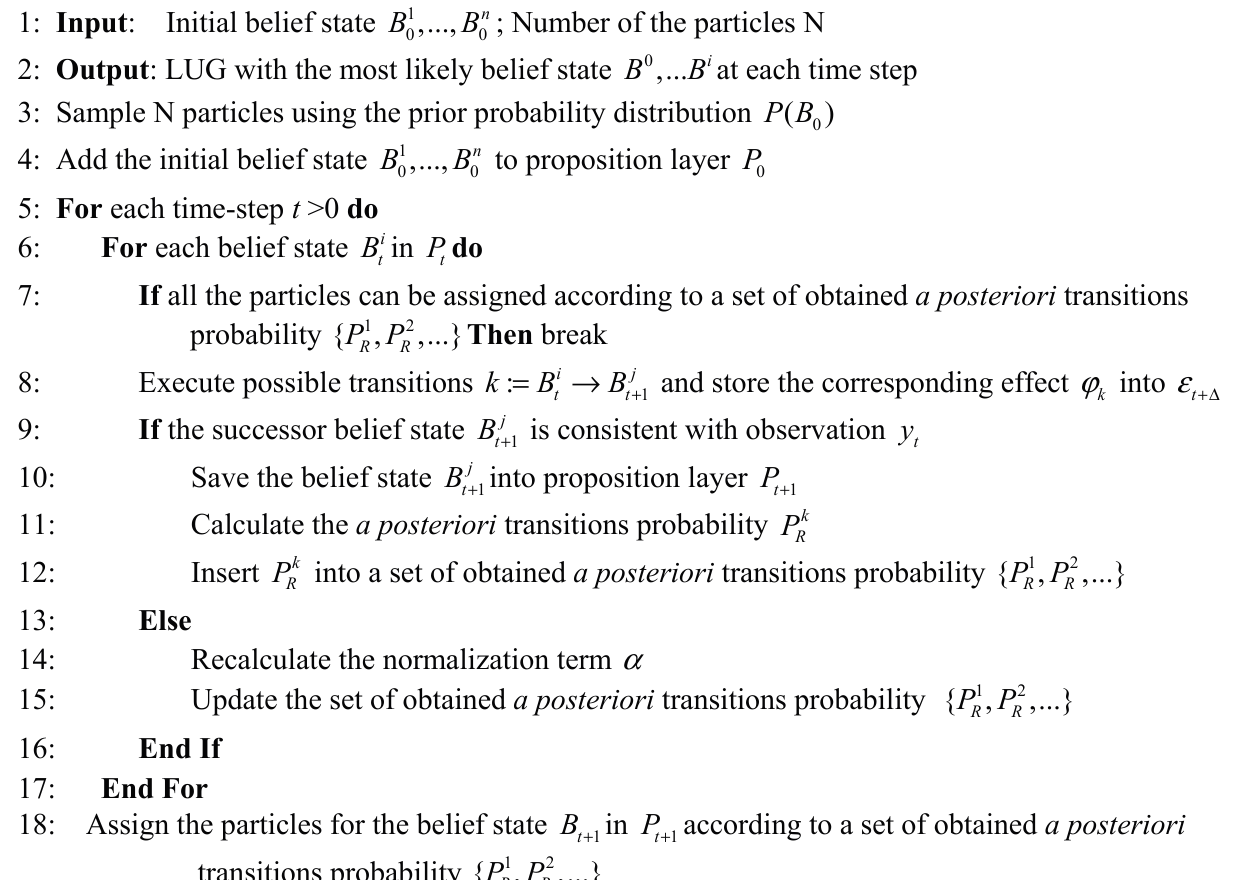
Algorithm 1 : Roll forward process